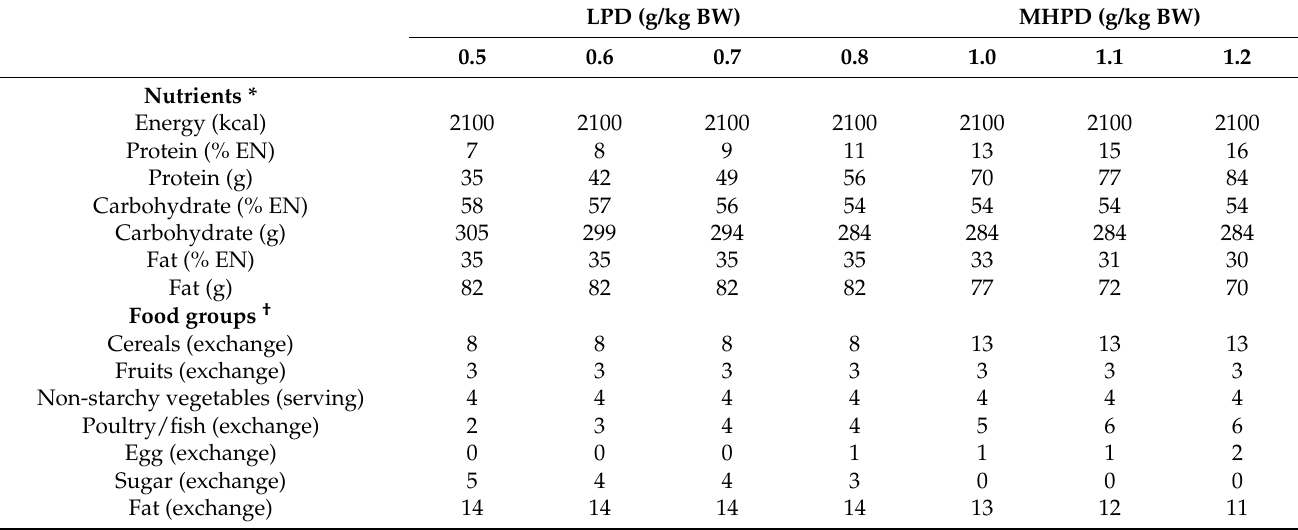
Table 1. Macronutrient distribution and food groups of a conventional